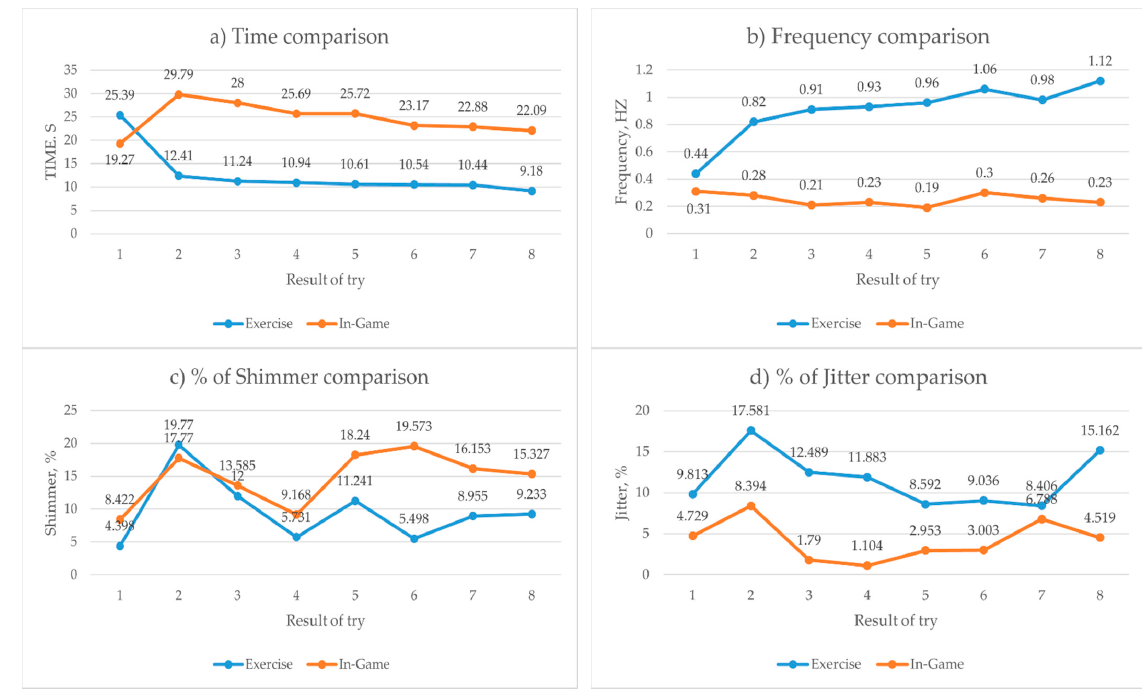
Figure 12. Visual representation of Exercise 4 result comparison in time, frequency, % of Shimmer and Jitter. Where ( a )—time value for each try of Exercise 4, ( b )—frequency value of each Exercise 4 try, ( c )—percent of shimmer value influence on signal for each Exercise 4 try, ( d )—percent of jitter value influence on signal for each Exercise 4 try.